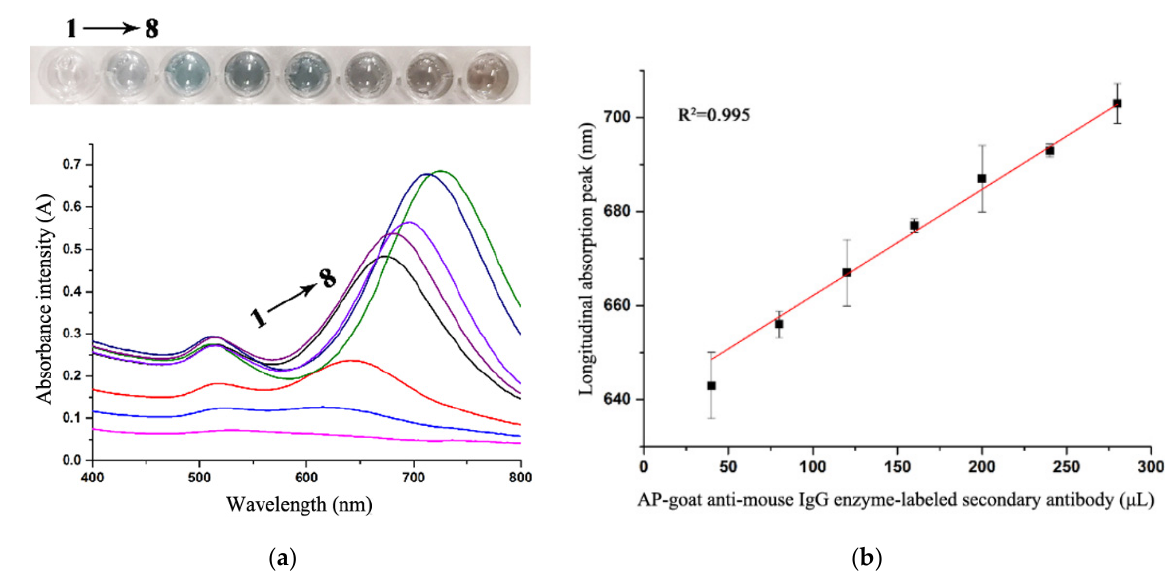
Figure 3. ( a ) UV-visible absorption spectra of AuNRs grown with different volumes of AP-labeled secondary Ab; ( b ) the standard curve of AP-labeled secondary Ab and longitudinal absorption peaks of AuNRs.